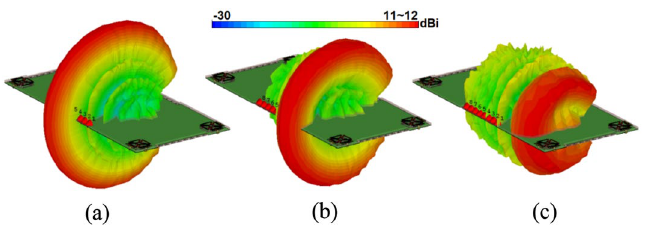
Figure 30. Radiation beam-steering of the phased array (placed at side-edge) at ( a ) 0, ( b ) 30, and ( c ) 60